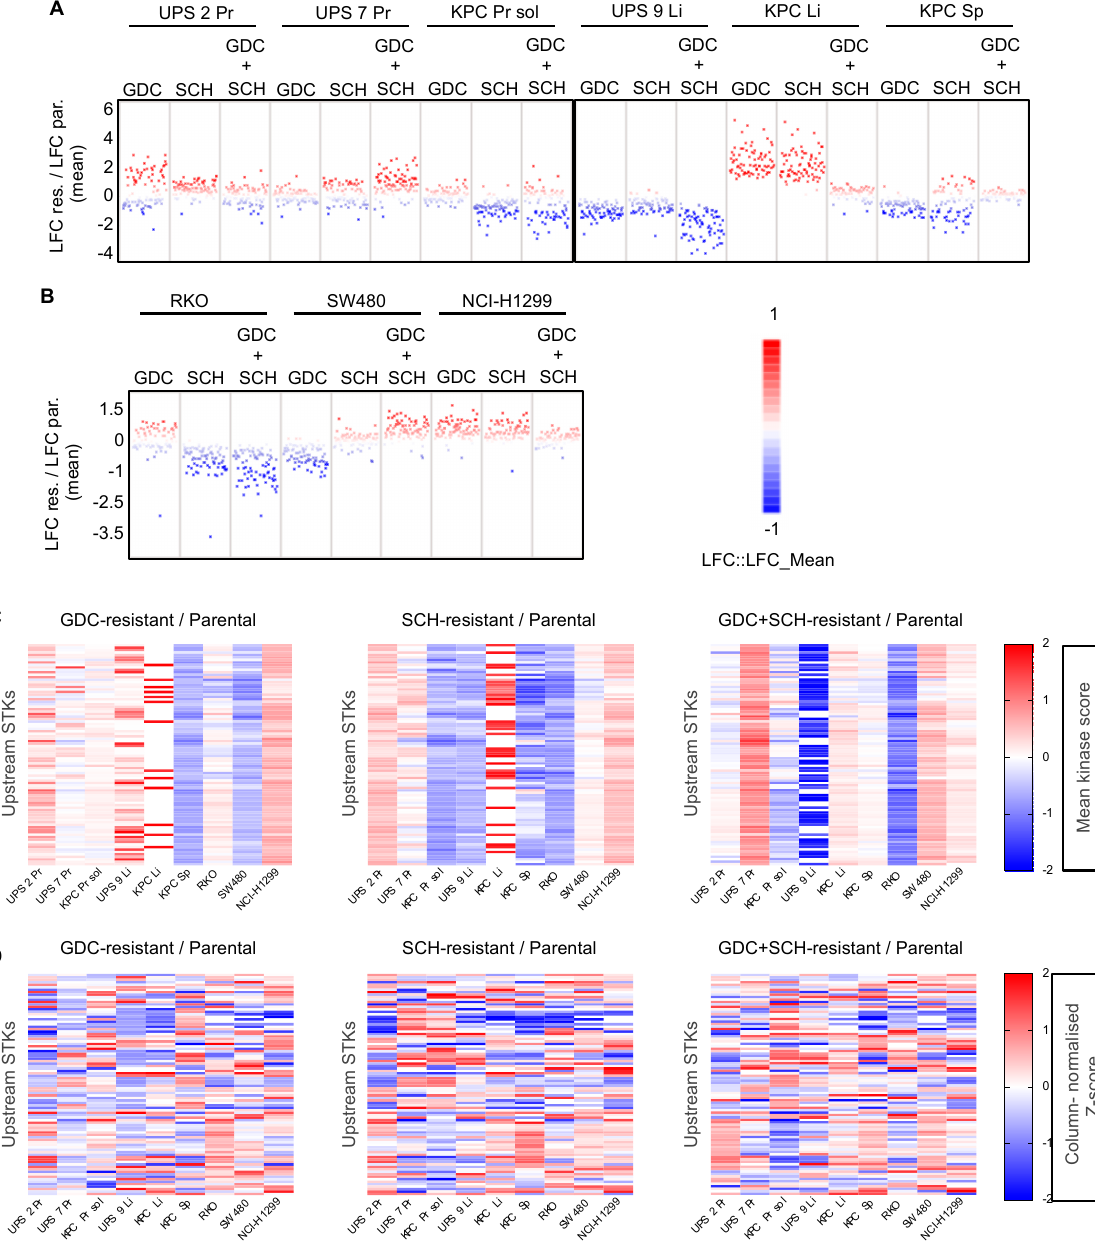
Figure 7. Patterns of STK activity in resistant cells. ( A , B ). Log 2 Fold Change (LFC) distribution of upstream STK kinase activity scores in resistant cell lines relative to their parental untreated counterpart in mouse ( A ) and human ( B ) cell lines. ( C ). Heatmaps depicting ratios of upstream kinase activity scores of resistant relative to parental cells organized by kinases on the Y-axis. ( D ). Heatmaps of column-normalized Z-scores based on upstream kinase activity scores of resistant relative to parental cells organized by kinases on the Y-axis. The Z-score acts as an intra-sample normalization to highlight relative differences in the activity of individual kinases compared to all kinases within the sample.